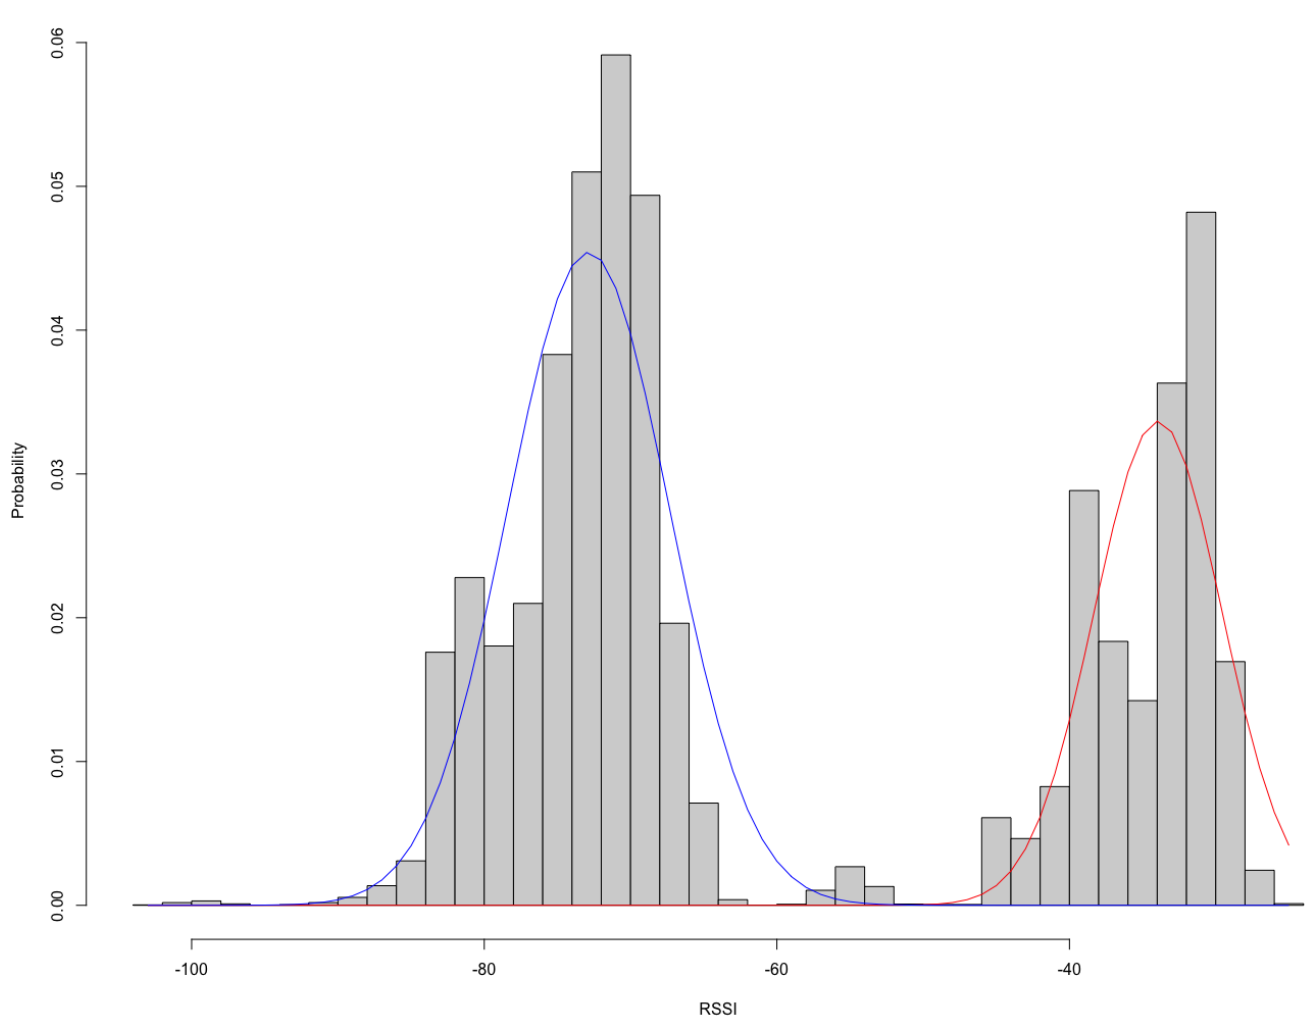
Figure 9. Histogram of teacher data; x axis is RSSI values and y axis is